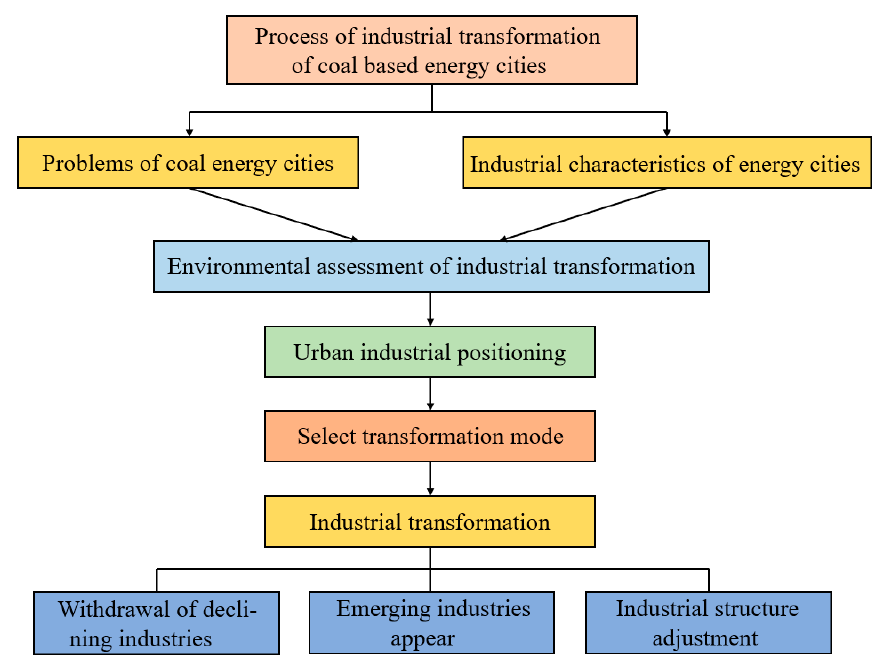
Figure 5. Flow chart of industrial transformation of coal energy-resource-based cities.